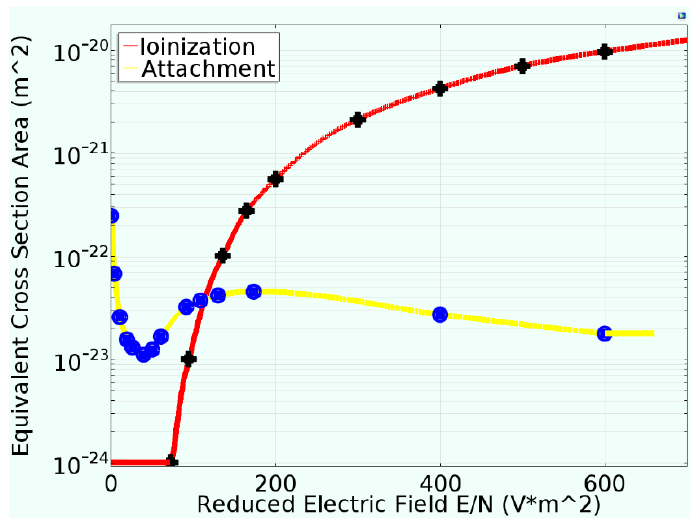
Figure 1. Ionization and electron attachment coefficients as functions of the reduced field E / N .